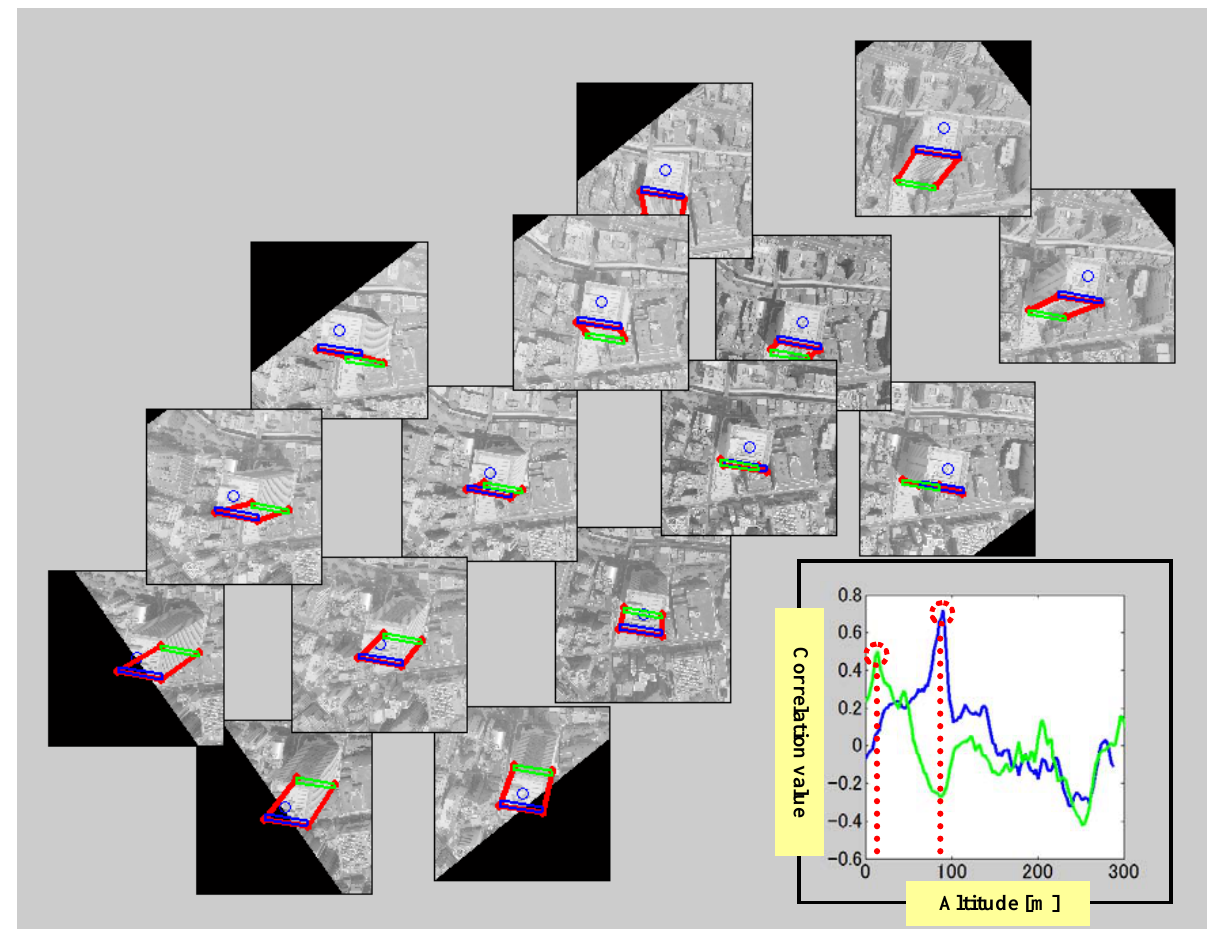
Figure 8. Plane Matching in Object-Space Searching (Red: Wall, Blue: Roof, Green: